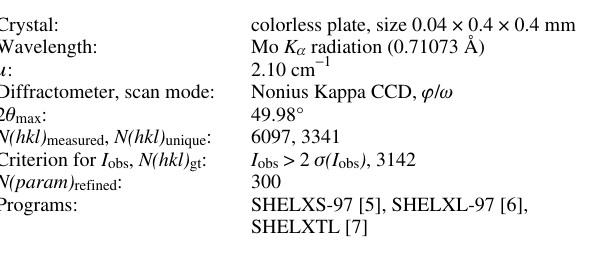
Table 1. Data collection and handling.